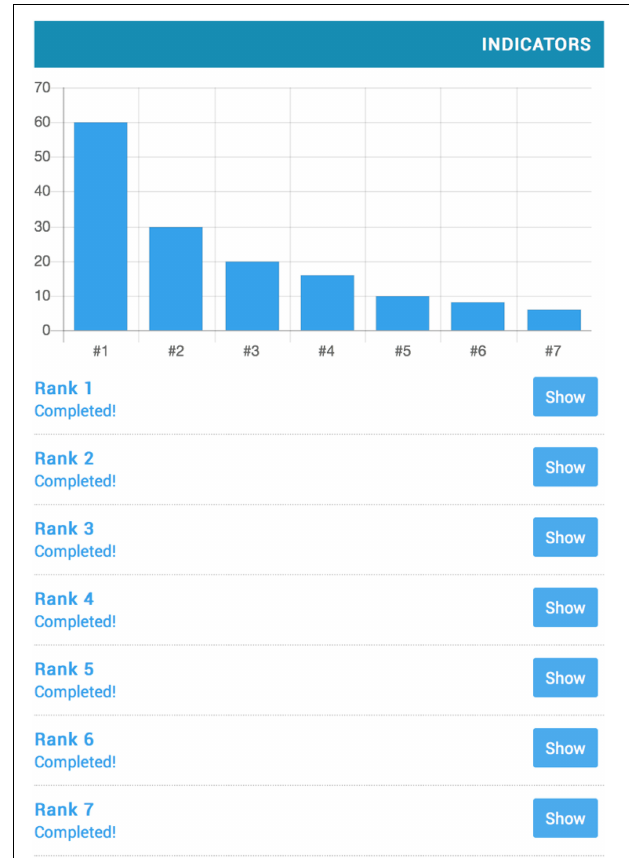
FIGURE 2 | The DMRS-Q forced distribution (image extracted from the DMRS-Q